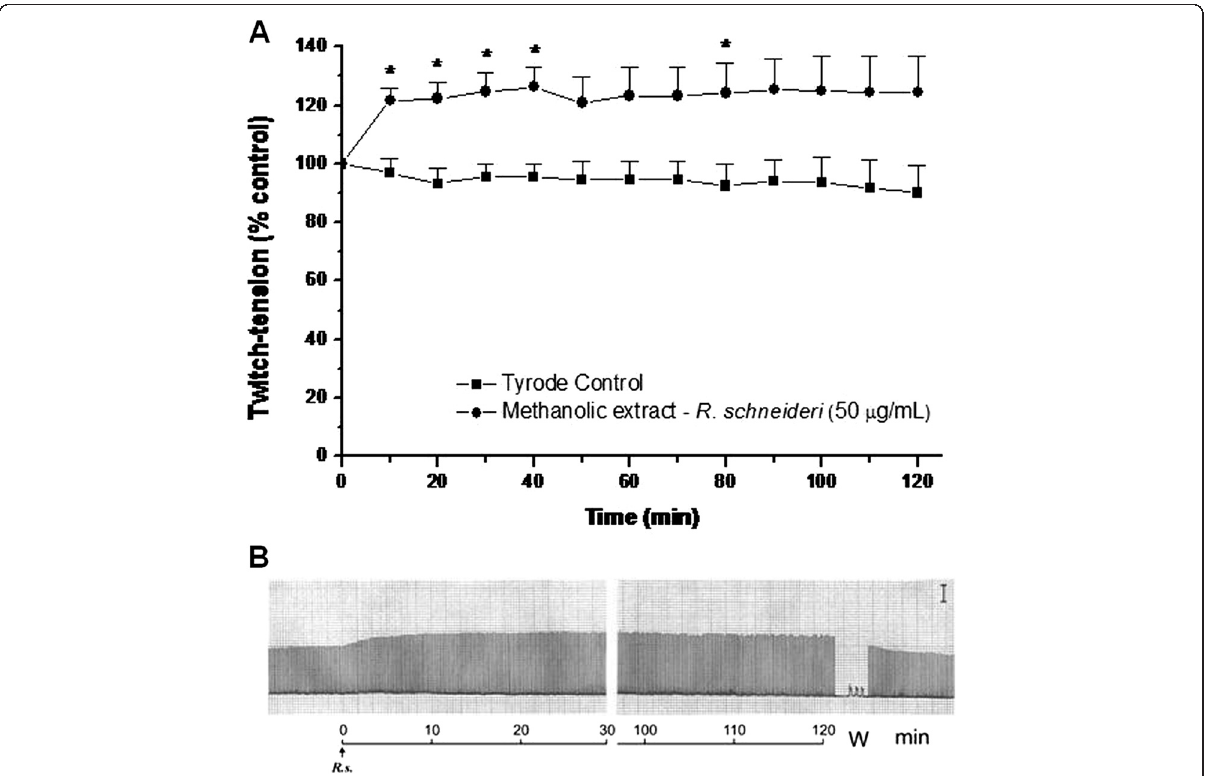
Figure 1 Neuromuscular activity of methanolic extract of R. schneideri in vertebrate nerve – muscle preparations. (A) Neuromuscular response produced by methanolic extract in indirectly stimulated mouse PND preparations. (B) Individual myographic record. Note the facilitatory response without neuromuscular blockade. (W, wash; Bar: 5 g). The points represent the mean ± S.E.M. of 5 – 6 experiments. * p < 0.05 compared to the twitch-tension at time